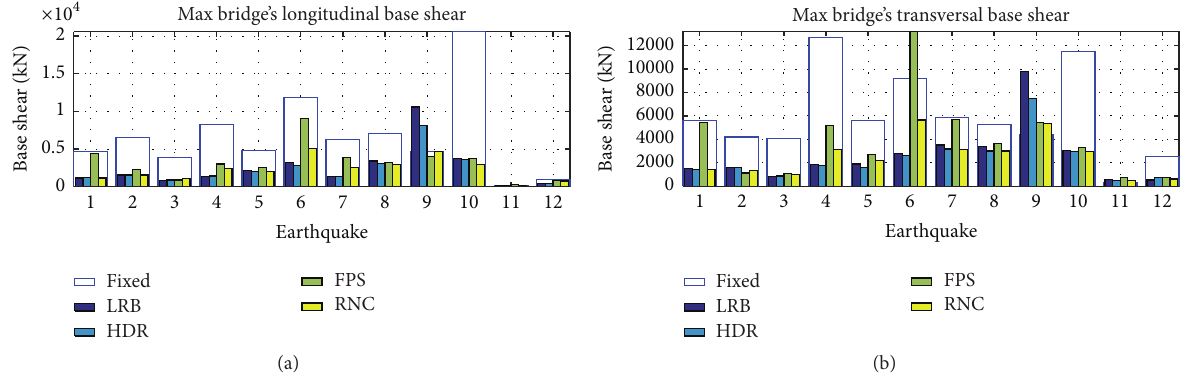
Figure 11: The bridge’s base shear in (a) longitudinal direction; (b) transversal direction.